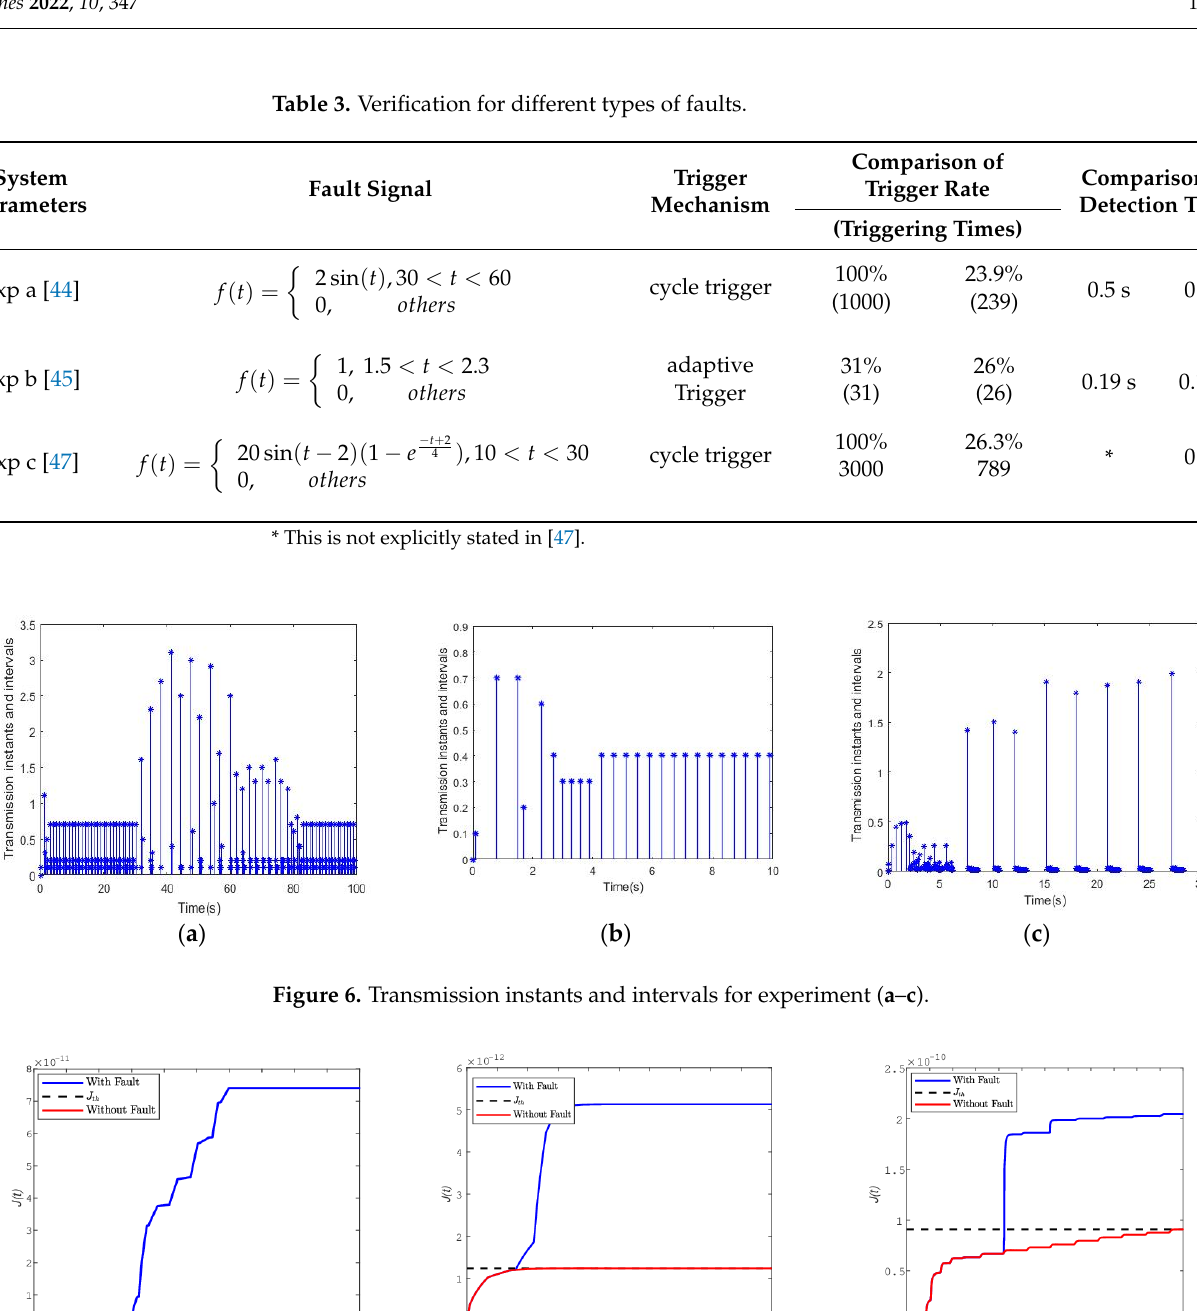
Figure 5. The trajectories of evaluation function with/without fault.